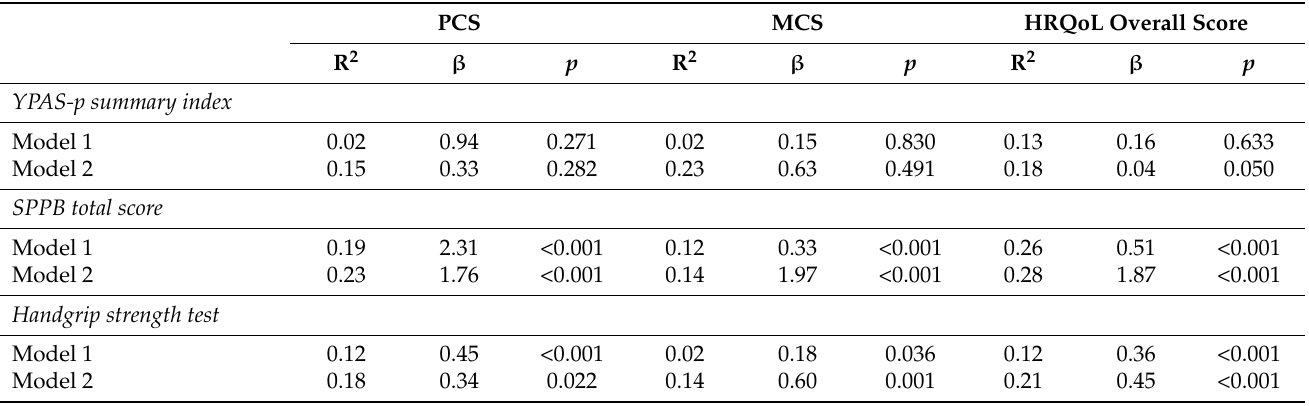
Table 4. Regression models for physical-functional fitness tests (SPPB and HGT) and physical activity levels (YPAS-p indexes) predicting health-related quality of life of older participants living in urban areas ( n = 139). PCS MCS HRQoL Overall Score R 2 β p R 2 β p R 2 β